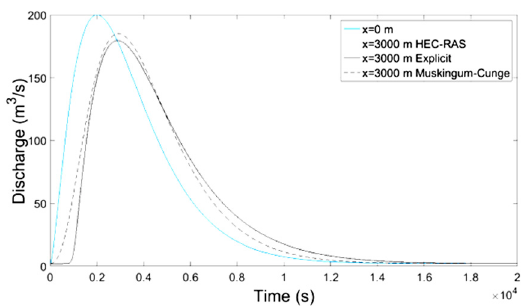
Figure 5. Discarge-Time at x = 3000